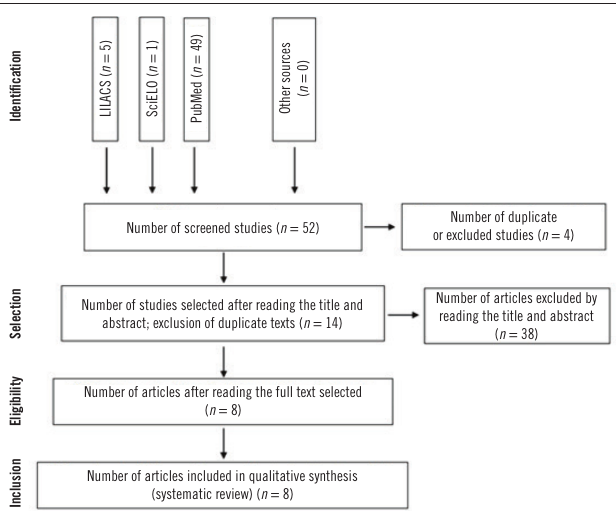
figure 1 – Flowchart of the selection steps of the elected studies for the systematic